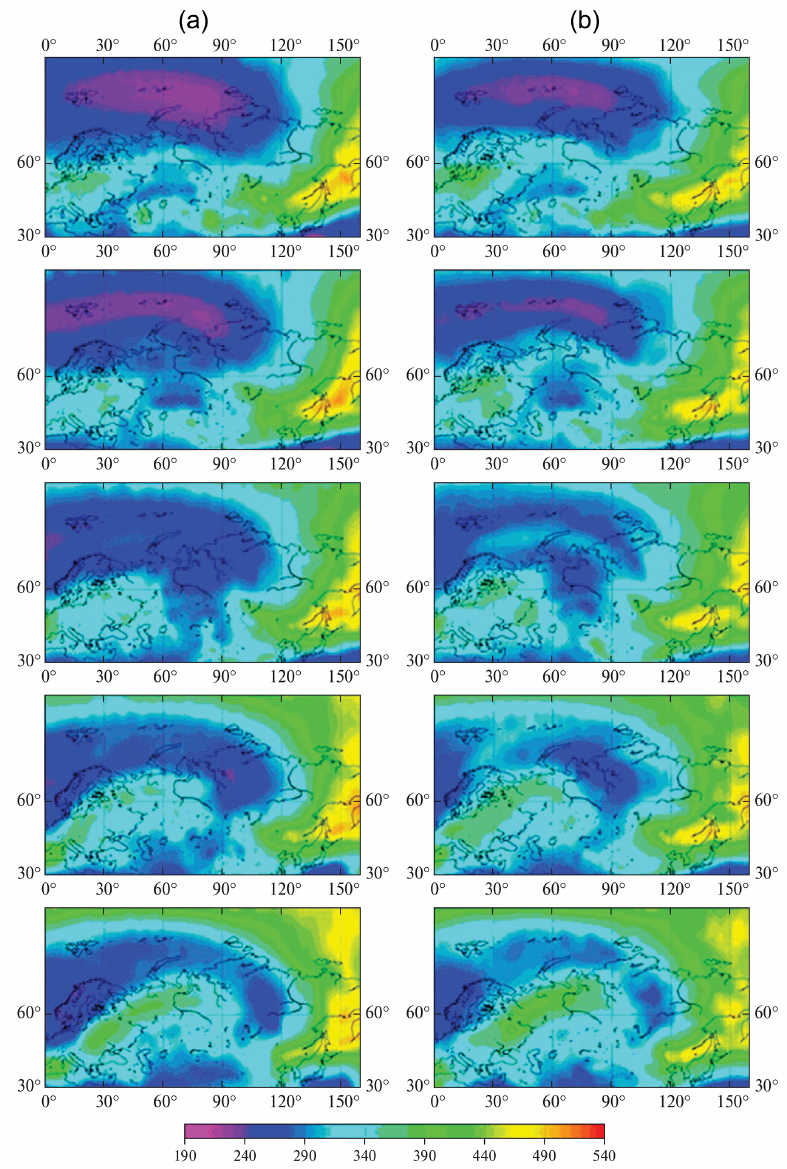
Figure 1. Spatial distributions of total ozone columns on 23–27 February 2016, based on measurements of two instruments of the same type – IKFS-2 (column a ) and IASI (column b ) (Garkusha et al., 2018).